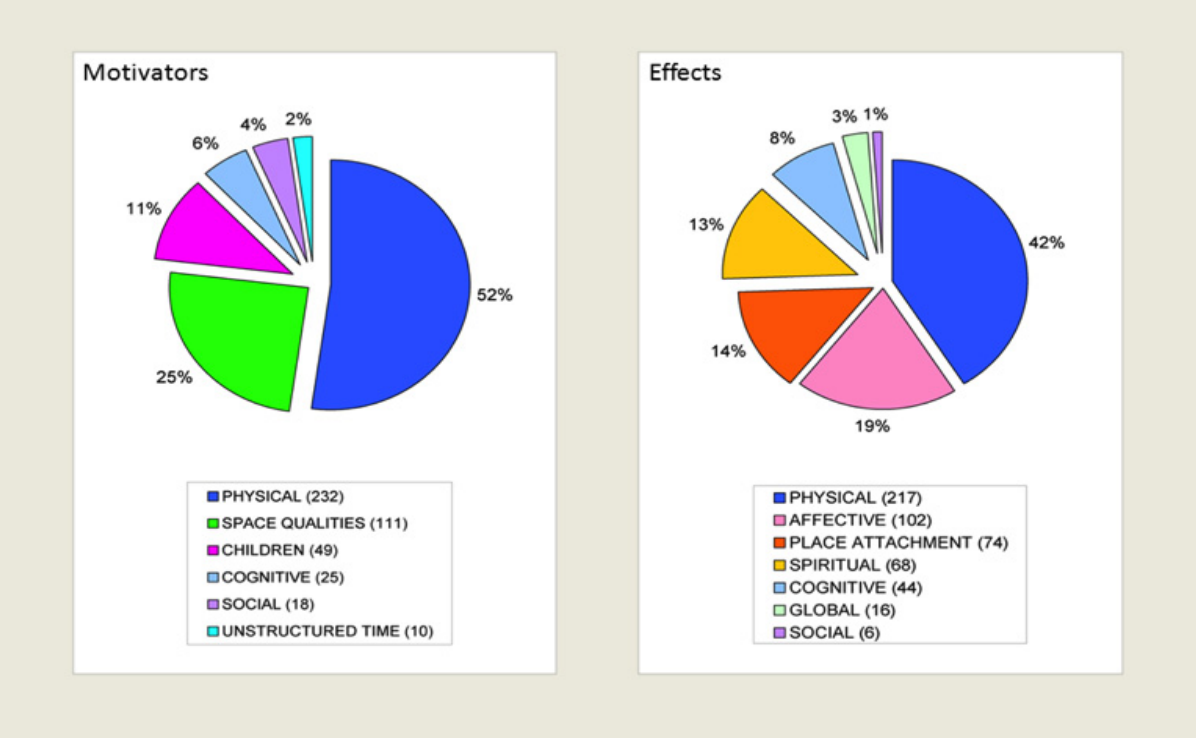
Figure 1. Relative endorsement of visit motivation for and derived effects from the use of urban green space. Domains associated with visit motivation ( left ) and derived effects ( right ) are depicted along with the number and percent of comments associated with each